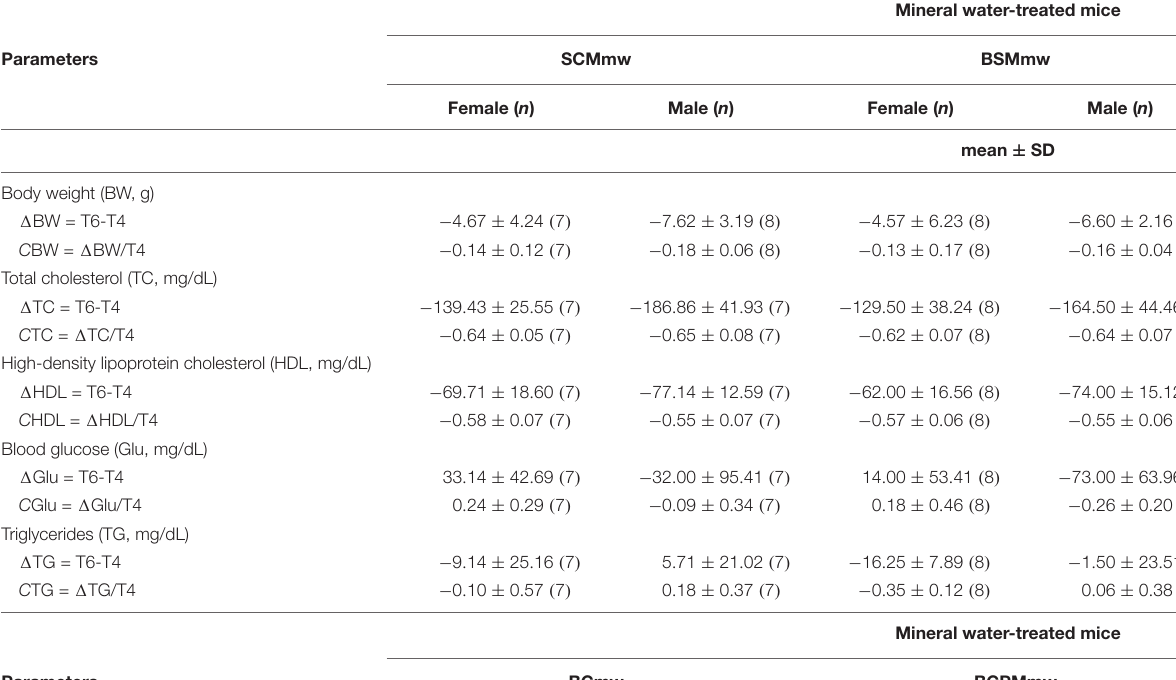
Mineral water-treated mice